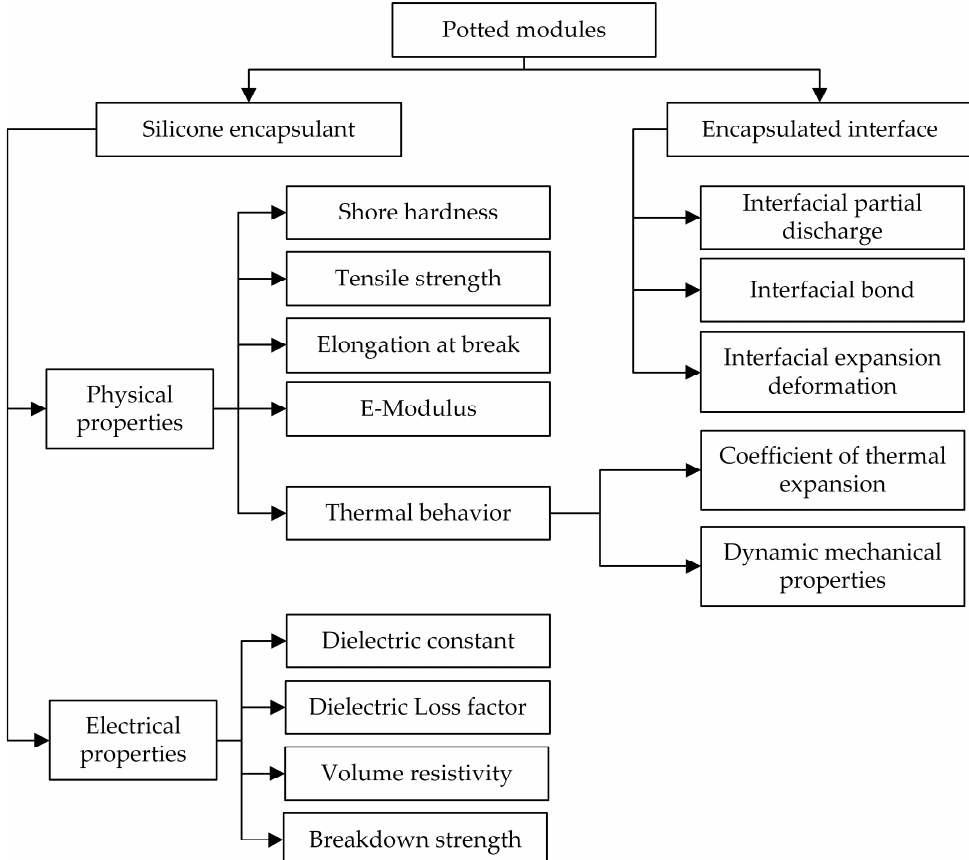
Figure 1. Test projects.